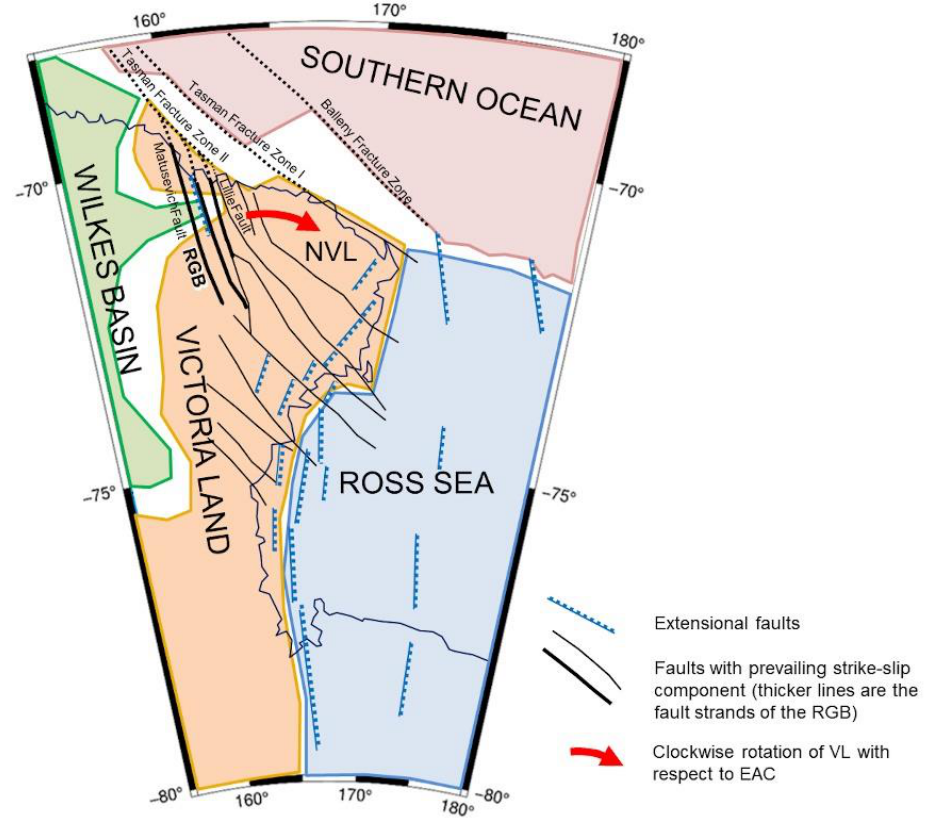
Figure 7. Geodynamic framework of VL region and its surroundings, characterized by four blocks with homogeneous geodetic and geophysical characteristics. The blocks are: the Southern Ocean to North (pink), the Ross Sea to the E (cyan), the Wilkes Basin to the W (green), and VL in between (orange).